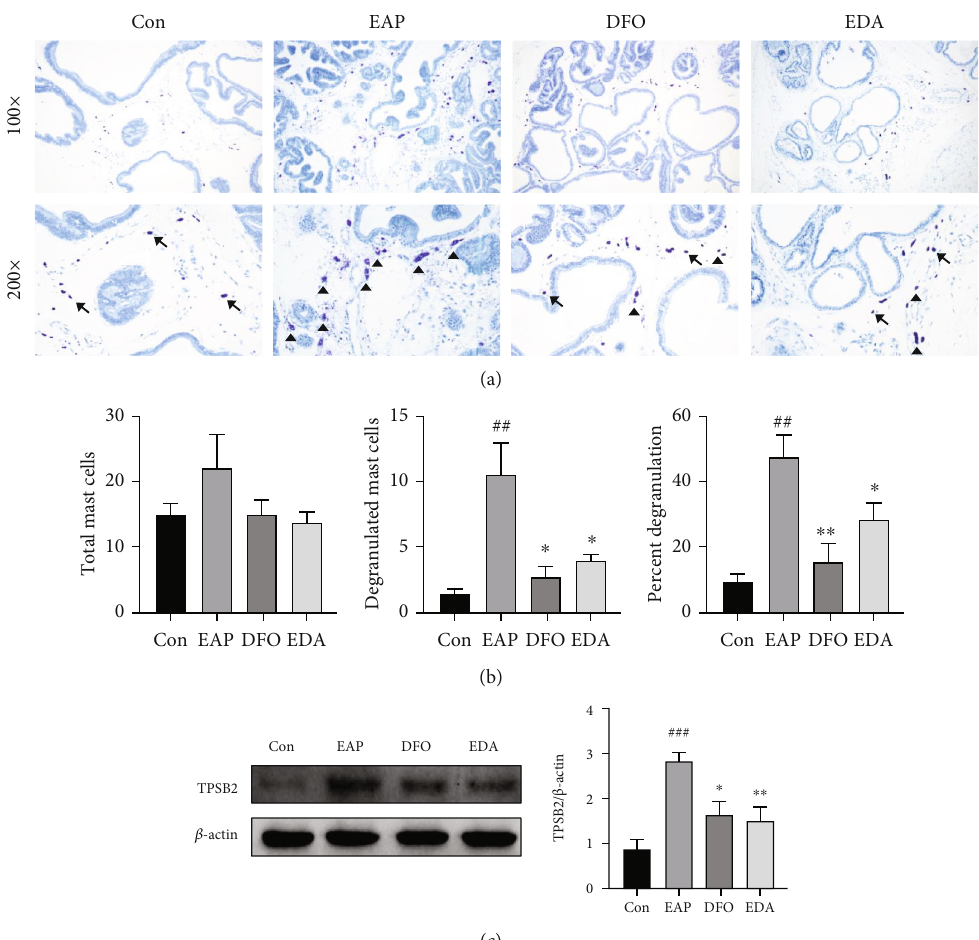
Figure 7: DFO and EDA suppressed mast cell activation in EAP model. (a) Toluidine blue staining to visualize mast cells in the prostate tissues. (b) The number of total, activated mast cells, and the percentages of activated ones were counted on the basis of toluidine blue staining under × 200 magni fi cation. The arrows indicate the silent (nongranulated) mast cells with intact cytomembrane, while the triangles indicate the activated (granulated) mast cells with di ff use metachromatic granules. (c) Western blot analysis of TPSB2 to re fl ect mast cell degranulation level in the prostate tissue. Relative quanti fi cation of TPSB2 was visualized. Data was presented as mean ± SEM . ## P < 0 : 01 versus the control group; ### P < 0 : 001 versus the control group; ∗ P < 0 : 05 versus the EAP group; ∗∗ P < 0 : 01 versus the EAP